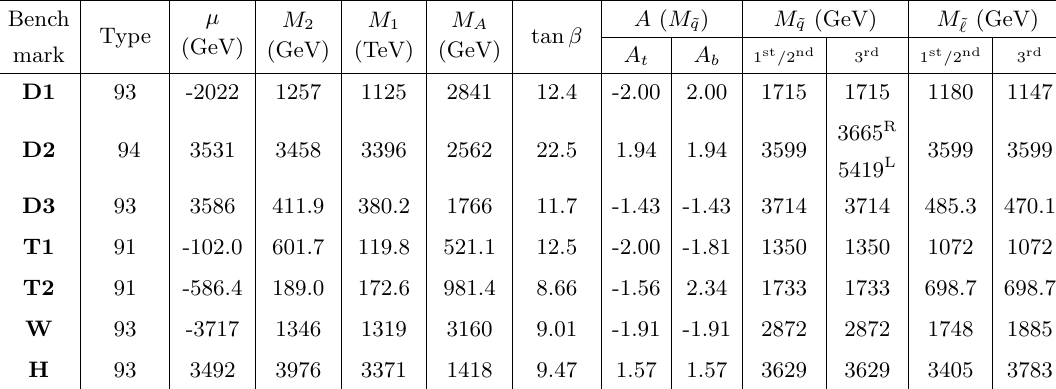
Table 6 . Benchmark models for which we show the resulting spectra of stable particles in (cid:12)gures 11{ 14, with model parameters for the various pMSSM-9 types introduced in section 5.1. A t=b are given in units of M ~ . Model D2 takes as input the right-handed stop mass (R), the left-handed third t R generation squarks mass (L), and otherwise assumes a common mass scale for all other sfermion mass terms. See table 7 for some phenomenological properties, and main text for more details.